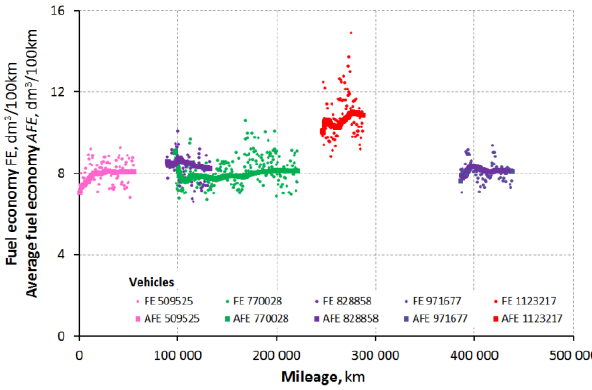
Fig. 1. A typical vehicles fuel economy between refueling (HEV LEXUS GS 450h) From the database, those cars were selected, the data of which covers both the beginning of operation and those with relatively high mileage. Detailed information is pre- sented further in Table 1.